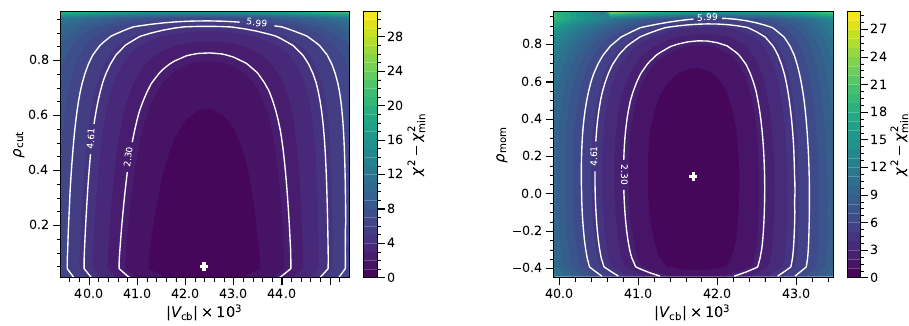
is subtracted from min